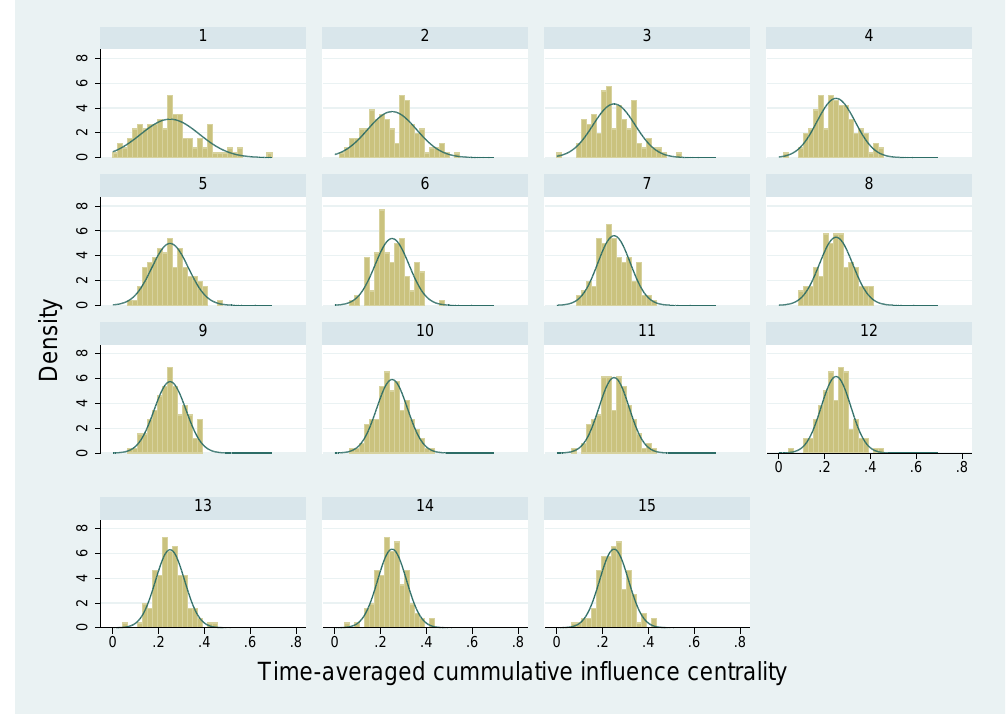
∑ s ( s ) = 1 C i ( t ) along the i t = 1 s